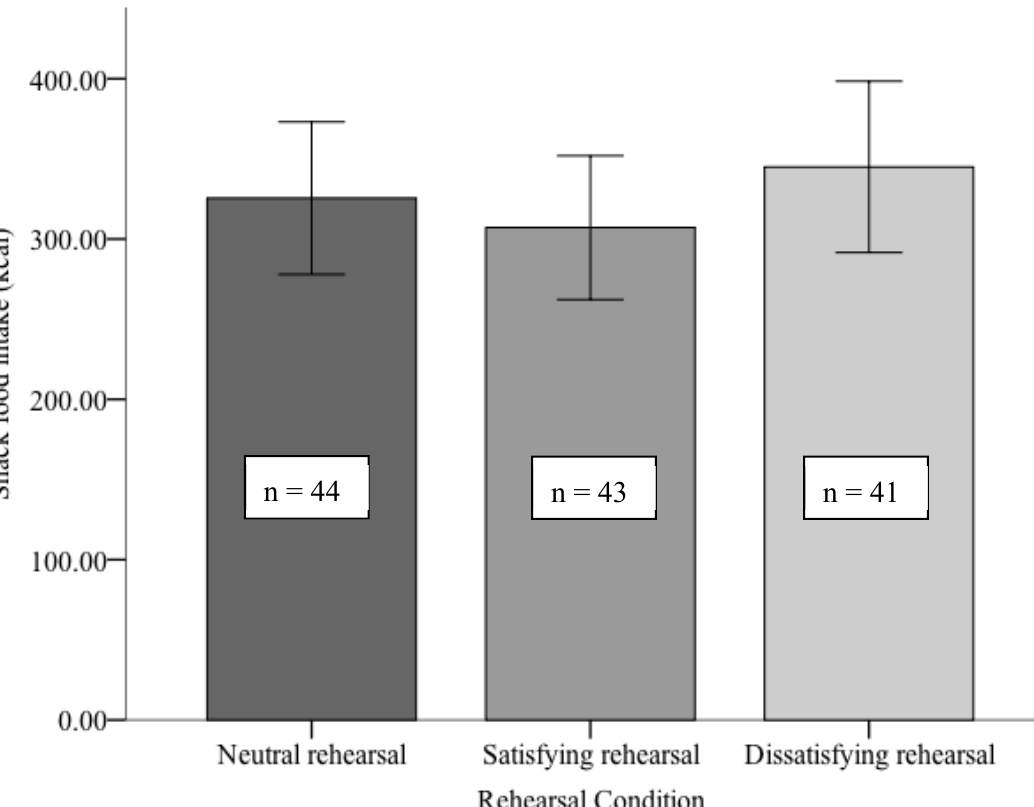
Figure 1. Snack food intake as a function of rehearsal condition (error bars represent 95% confidence intervals).